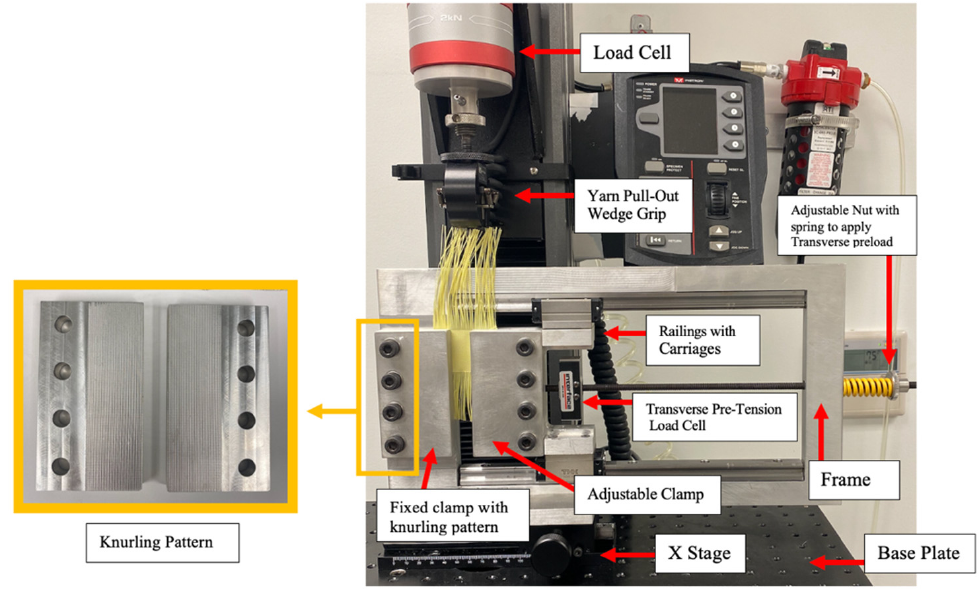
Figure 4. Quasi ‐ static yarn pull ‐ out test setup in an Instron machine. Figure 4. Quasi- static yarn pull-out test setup in an Instron